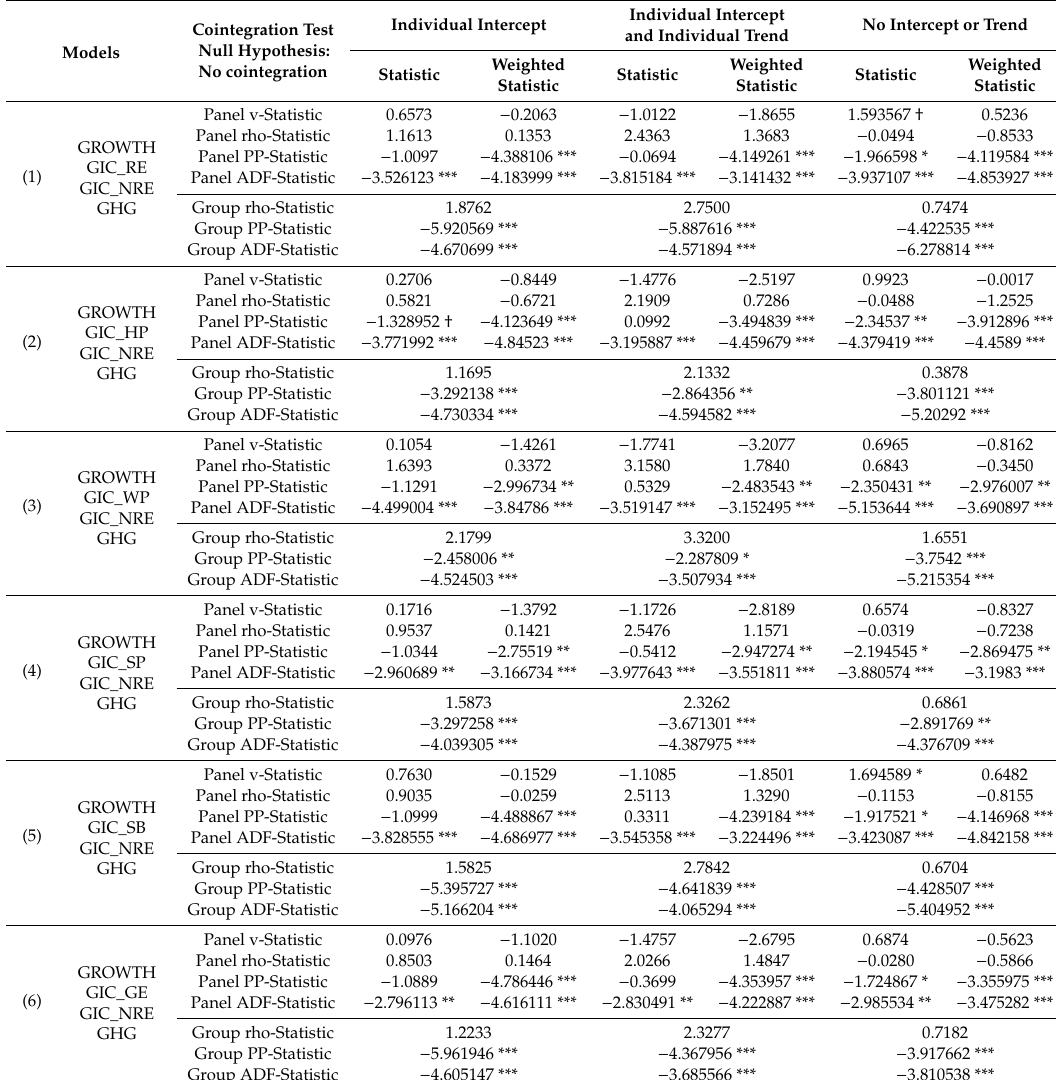
Table 11. Pedroni (Engle Granger based) panel cointegration test results.